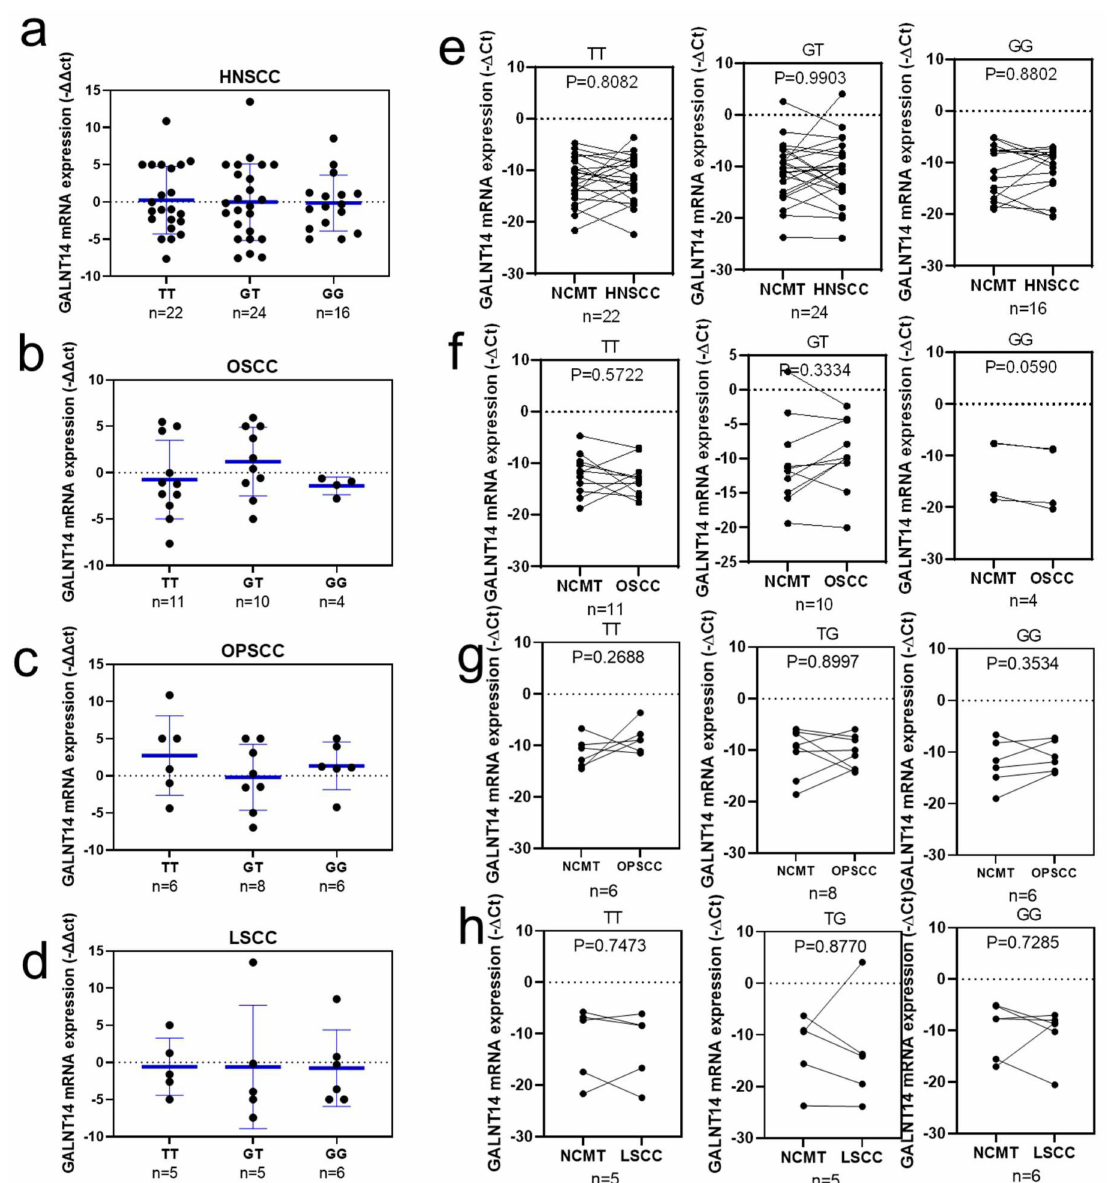
Figure 3. GALNT14 mRNA expression levels of GALNT 14 -rs9679162 genotypes in HNSCC, OSCC, OPSCC, and LSCC. GALNT14 mRNA expression level (circle, − ∆∆ Ct of each paired tissue; blue lines, mean ± SD) in the three GALNT14 -rs9679162 genotypes in ( a ) HNSCC, ( b ) OSCC, ( c ) OPSCC, and ( d ) LSCC. GALNT14 mRNA upregulation or downregulation (circle, − ∆ Ct of each tissue) trend with respect to GALNT14 -rs9679162 genotypes in paired NCMT and ( e ) HNSCC, ( f ) OSCC, ( g ) OPSCC, and ( h ) LSCC samples. n, sample size. One-way ANOVA was used to analyze the data in ( a – d ), and paired t -test was used for ( e – h